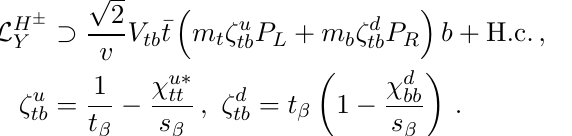
(cid:22) t ( b ) H + (solid) at p s = 8 TeV as a function of (a) (cid:31) u Figure 3 . Production cross-section of pp ! and (b) t (cid:12) , where the (cid:12)xed values of parameters are given in the plots, K = 1 : 3 is the K -factor for the radiative QCD corrections, and the dashed line denotes the CMS upper